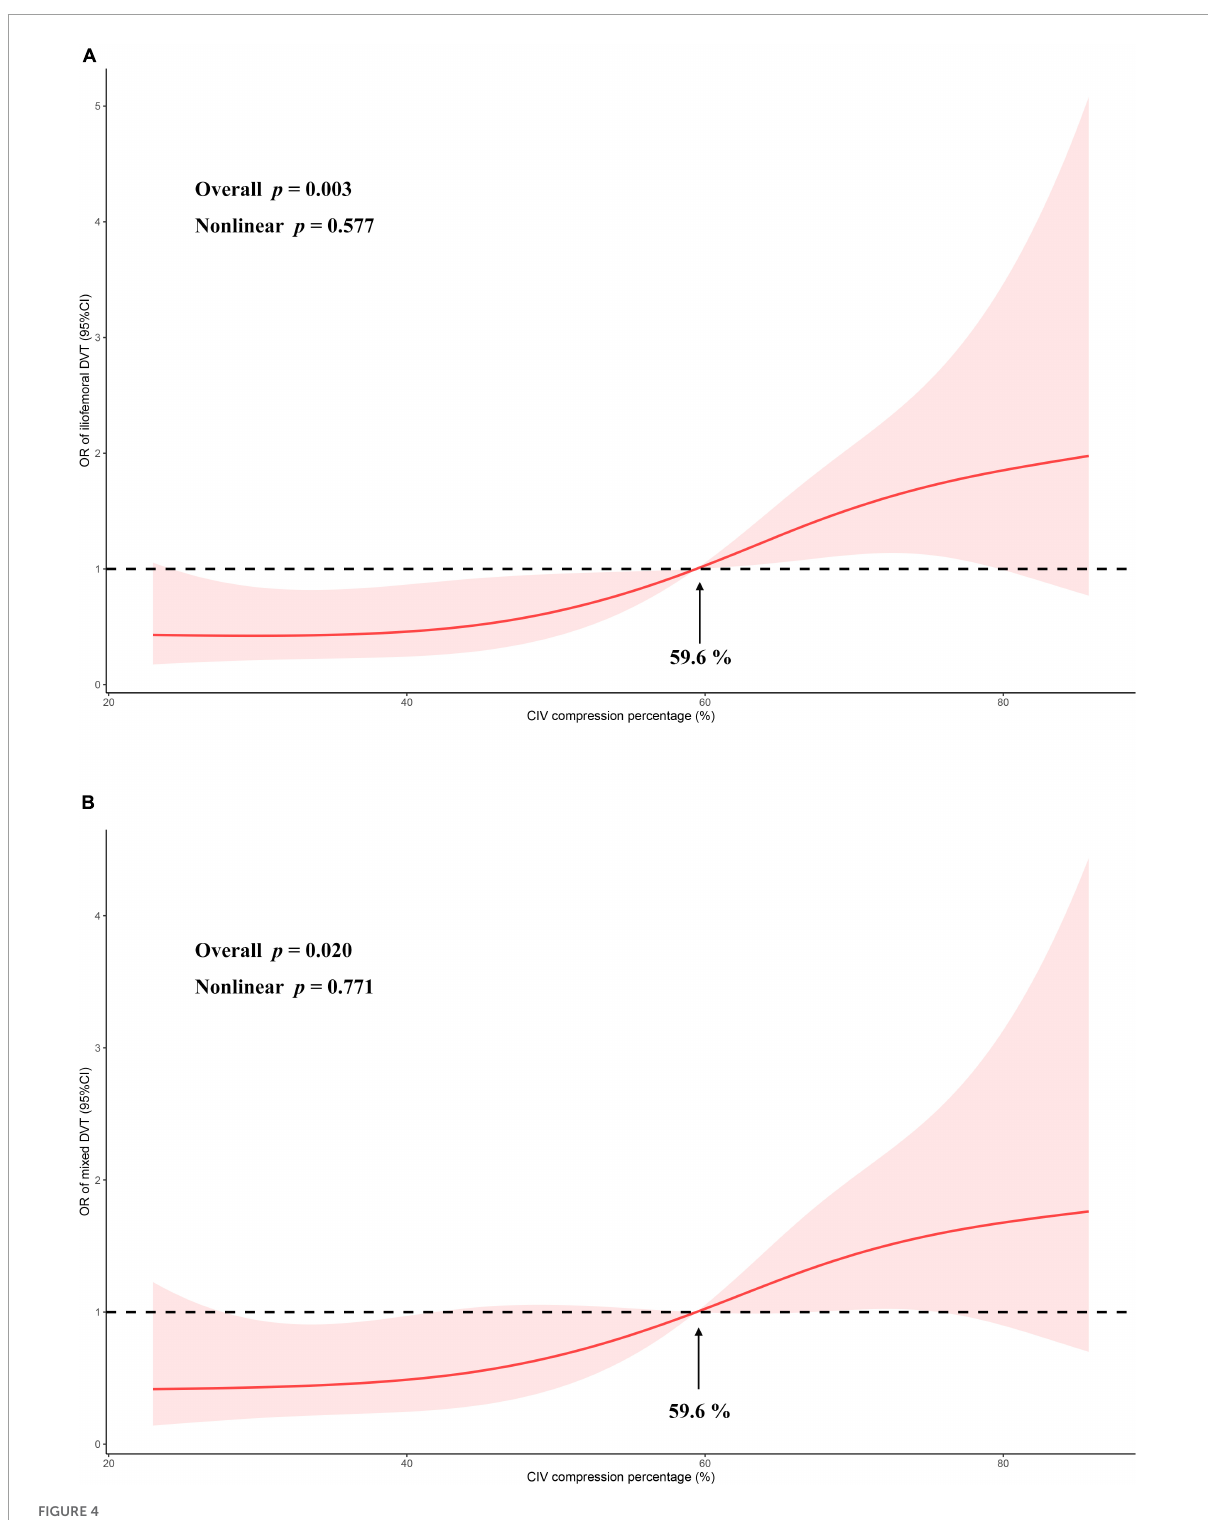
FIGURE4 The odds ratio of CIV compression percentage vs. iliofemoral DVT (A) or mixed DVT (B) is modeled using logistic regressions with restricted cubic splines with 95% confidence limits (red ribbon). Analysis between compression percentage and iliofemoral DVT was adjusted for age, sex, D-dimer level, and cancer. Analysis between compression percentage and mixed DVT was adjusted for age and sex. The black dashed lines indicate reference lines for no association at an odds ratio of 1. Knots are set at the 5th, 35th, 65th, and 95th percentiles of CIV compression percentage. OR, odds ratio; CIV, common iliac